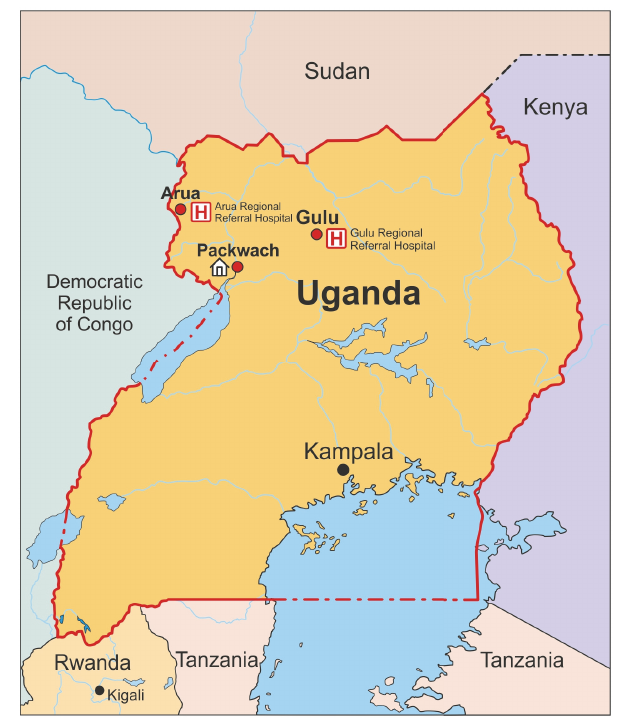
Figure 2: A map of Uganda showing the patient’s hometown and the two regional referral hospitals where she could access HIV and cryptococcal meningitis care